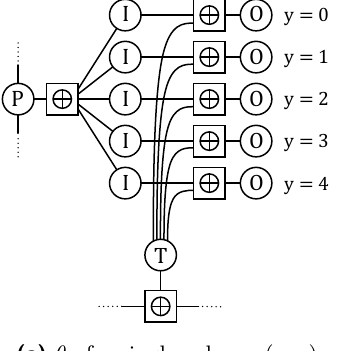
are given the probability distributions of two c -bit variables (clusters) X, Y , and want to compute the distribution of Z = X ⊕ Y . We can then write Pr ( X ⊕ Y = z ) =